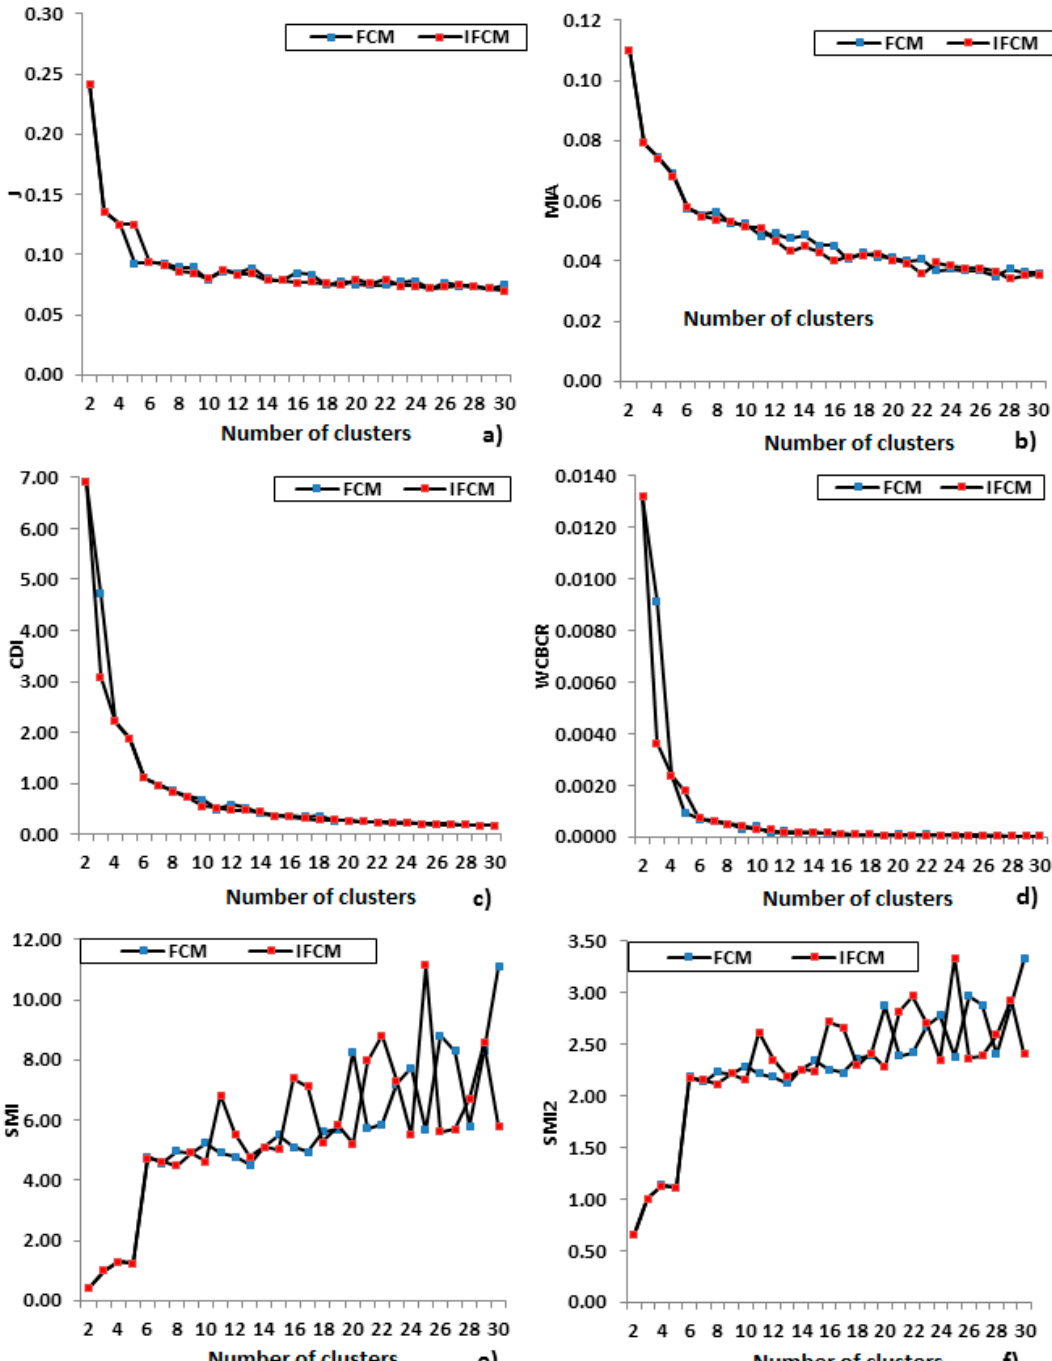
Figure 5. Comparison of the fuzzy algorithms using: ( a ) J, ( b ) MIA, ( c ) CDI, ( d ) WCBCR, ( e ) SMI, ( f ) SMI2.